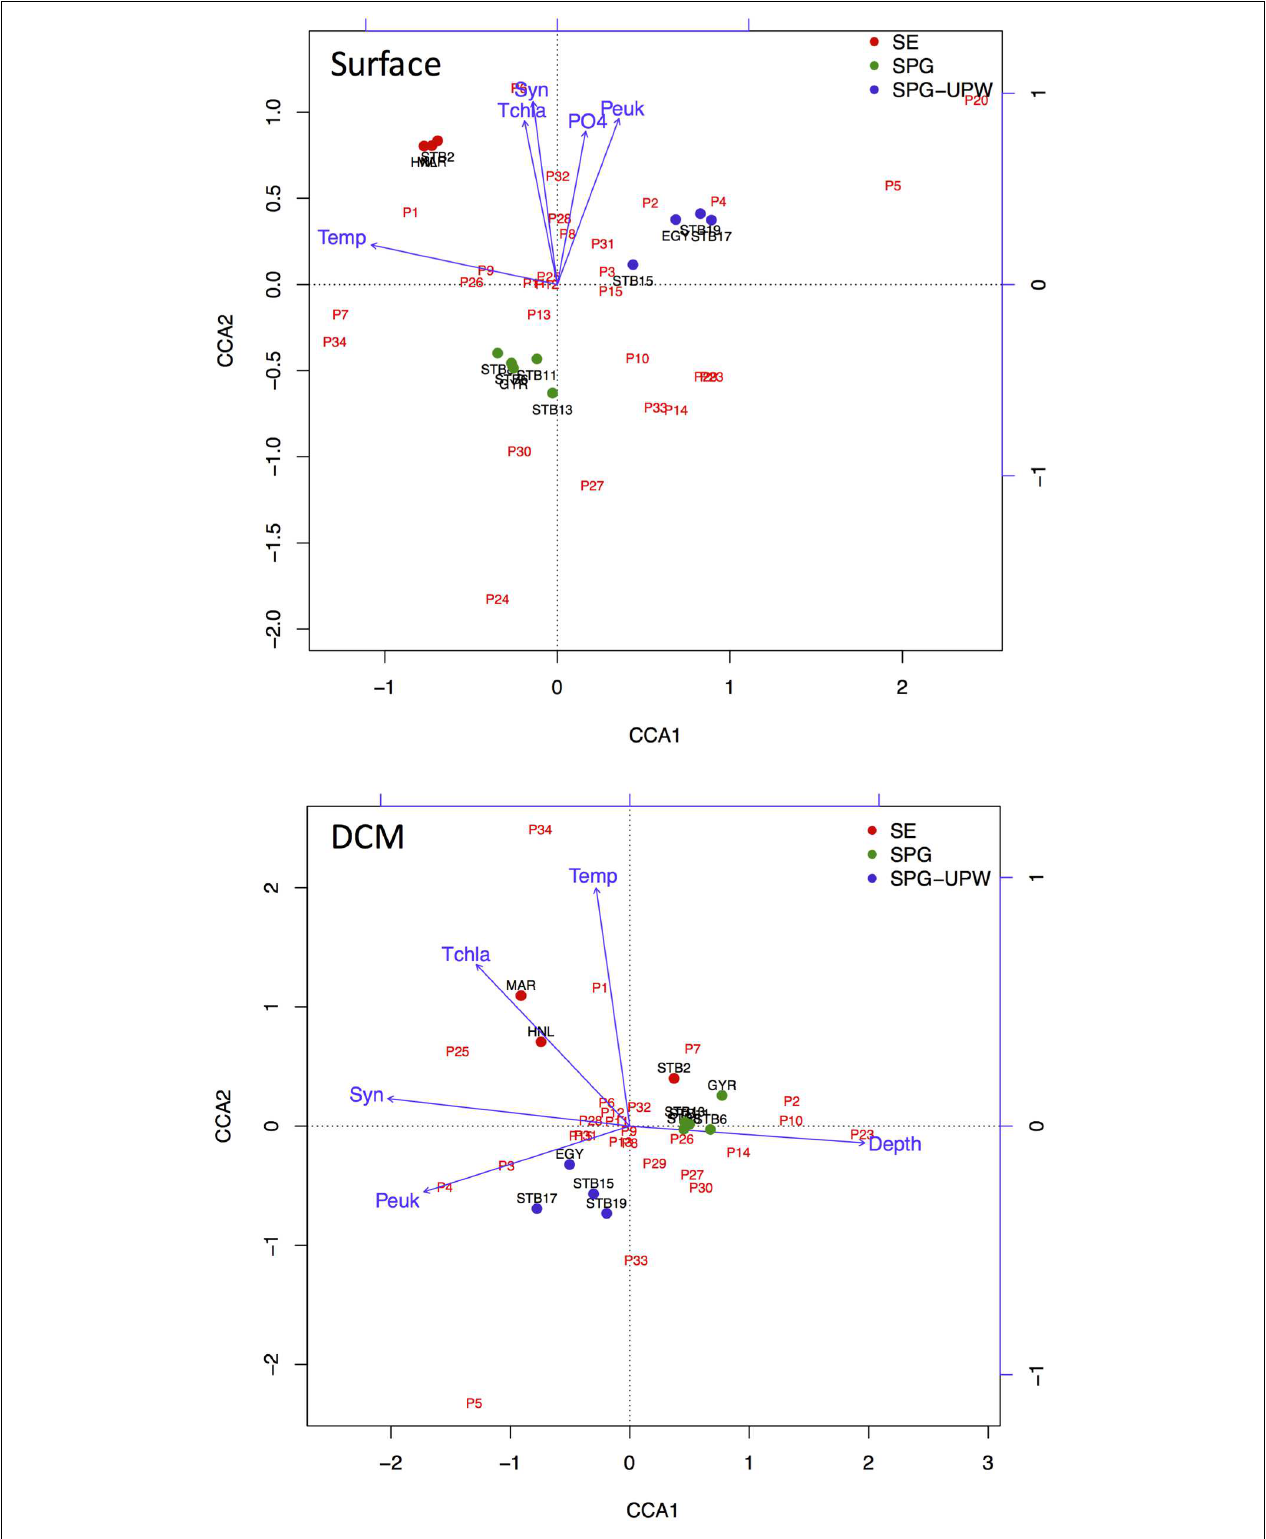
FIGURE 6 | CCA ordination triplots of Axes 1 and 2 for surface and DCM bacterial communities with respect to the environmental variables temperature (Temp), depth (Depth), nutrients phosphate (PO4), total chlorophyll a (Tchla), and picoplankton cell concentrations, Synechococcus (Syn) and picoeukaryote (Peuk). Bacterial OTUs from SSCP peaks are indicated in red and stations from MAR to STB19 are color coded according to water mass.